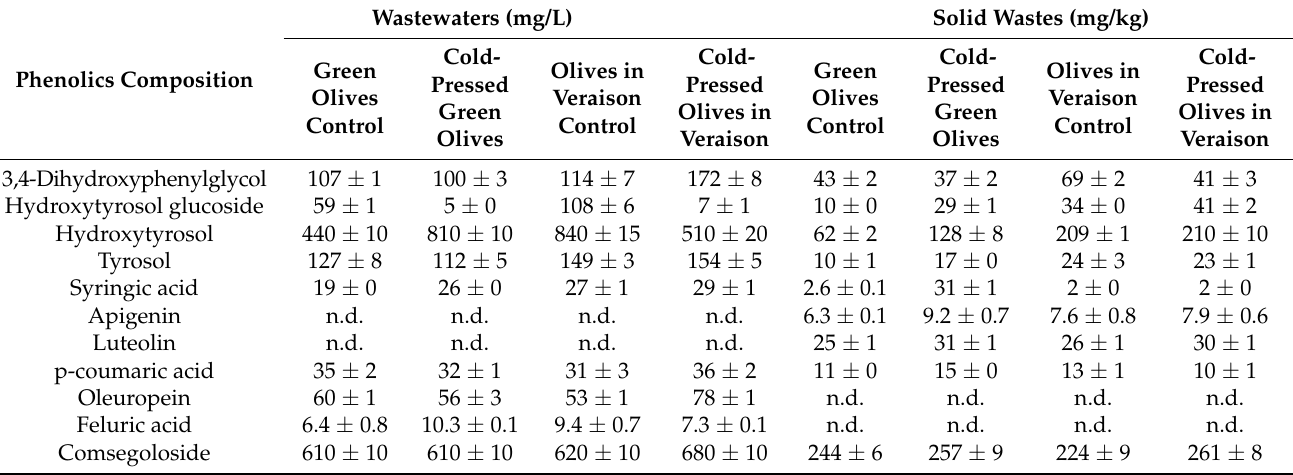
Table 2. Composition of the main individual phenolics in the liquid fractions (wastewaters) and the solid waste fractions as determined by HLPC. n.d.: not